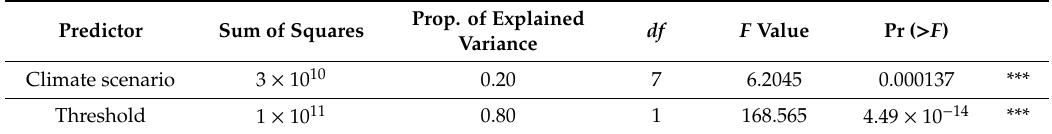
Table 1. Results of the linear model to determine the most important climate scenario between those used. The statistical significance is expressed as follow: 0 ≤ *** < 0.001.